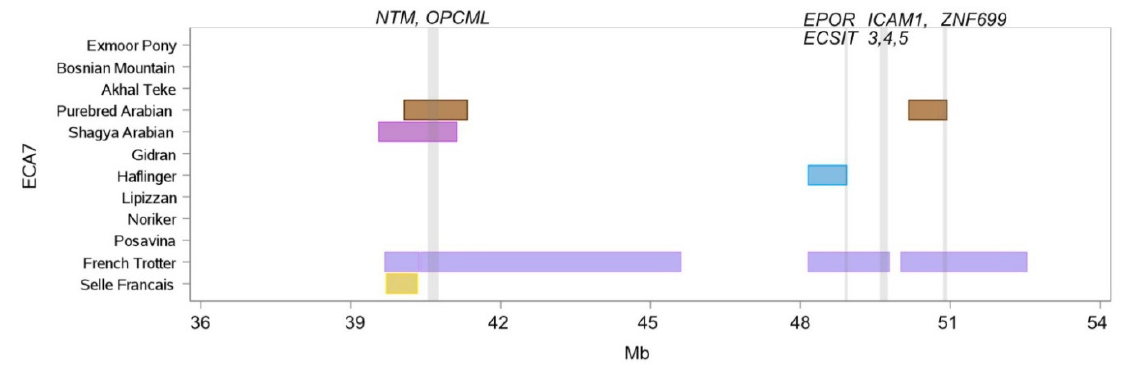
Figure 5. ROH islands on ECA7 between 36 Mb and 54 Mb. Location and length of ROH islands (shared by more than 50% of individuals per breed) per breed are illustrated as horizontal boxes, location of genes of specific interest are indicated as vertical lines.